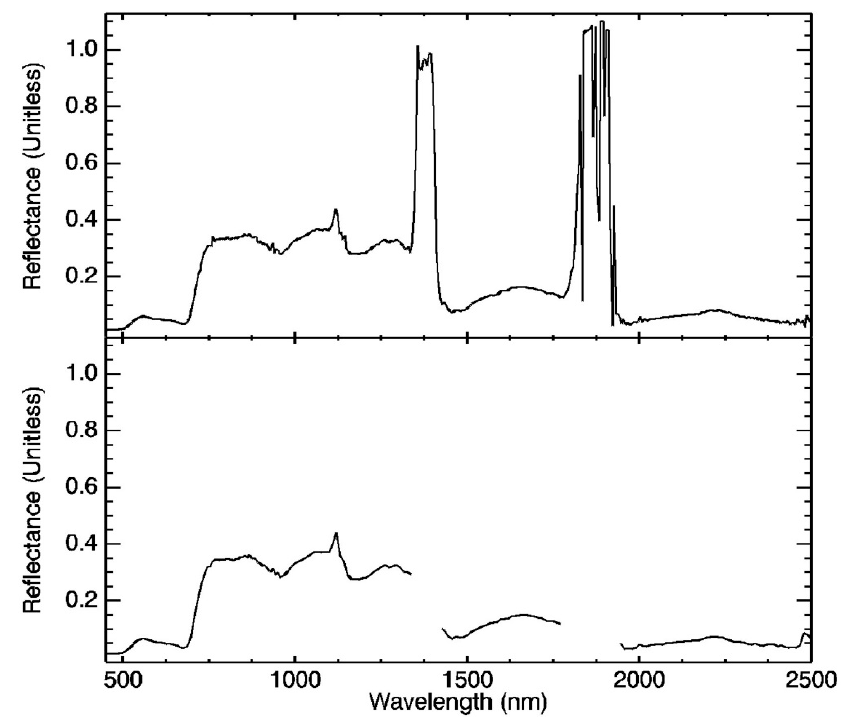
Figure 4. An example of the effect of spectral binning on the spectral profile of a single pixel of vegetation. The top panel shows the unbinned profile with 457-bands and the bottom panel shows the profile from 2x-binned 229-bands. Note the increased noise in the unbinned profile (top panel). Once all flight lines were orthorectified, radiometrically corrected, and spectrally binned, they were mosaicked together to produce a single georeferenced hypercube image of the flight area. It was ensured that at least 25 tie points were found between two adjacent flight lines, leading to an RMSE for each flight area of less than 0.5